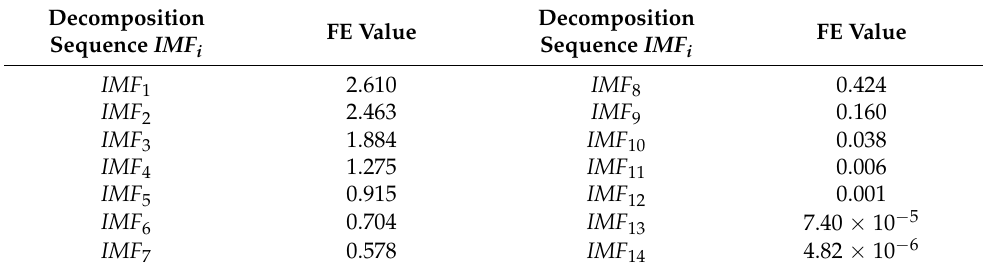
Table 2. Sample entropy of decomposed wave IMF i